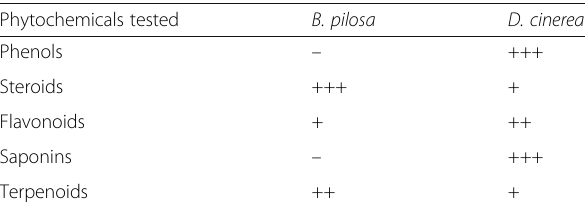
Table 1 Phytoconstituents of B. pilosa and D. cinerea leaf extracts